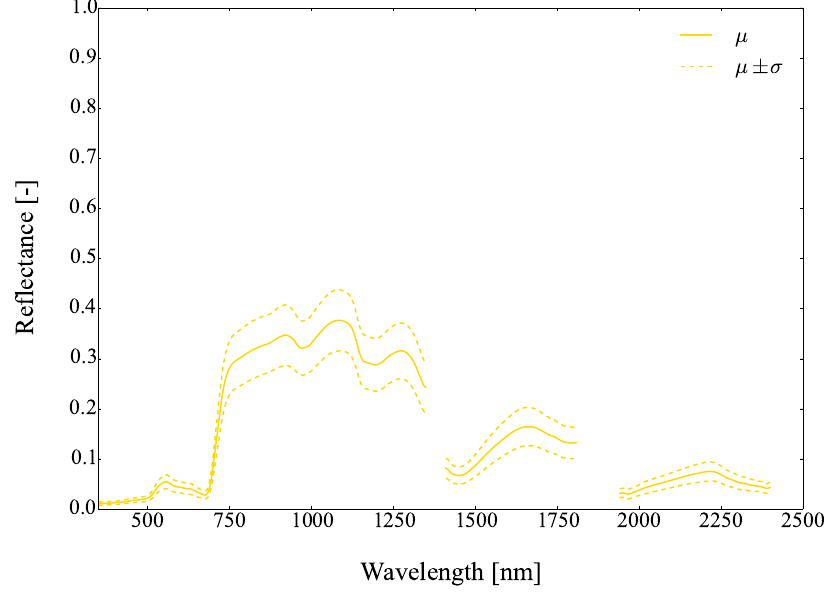
Figure A14. Mean reflectance ( µ ) and standard deviation ( σ ) of Rhododendron ferrugineum